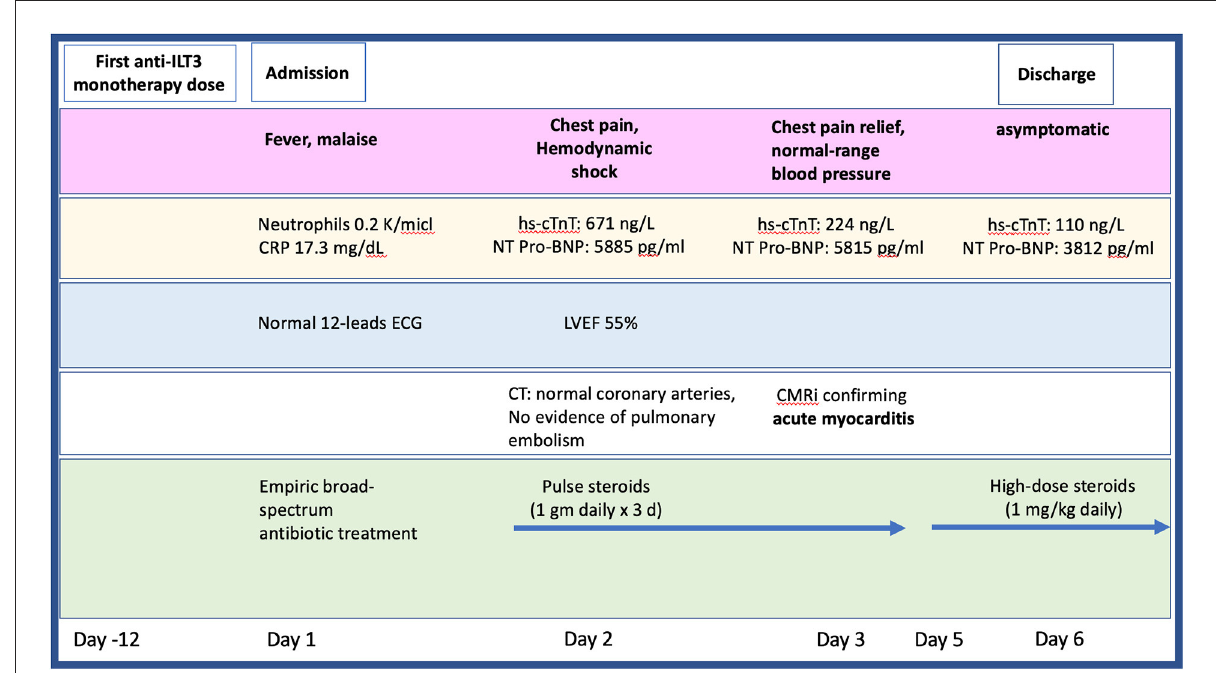
FIGURE1 Timeline presenting the patient’s clinical presentation, diagnostic findings, and treatment approach during hospitalization. CMR, cardiac magnetic resonance imaging; CT, computed tomography; ECG, electrocardiogram; hs-cTnT, high sensitive troponin; LVEF, left ventricular ejection fraction; NT pro-BNP, N-terminal pro-brain natriuretic peptide.